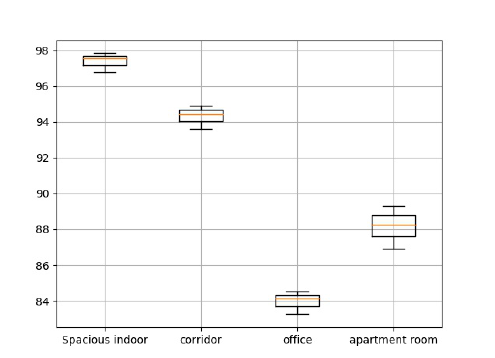
Figure 12. Accuracy of motion recognition in different